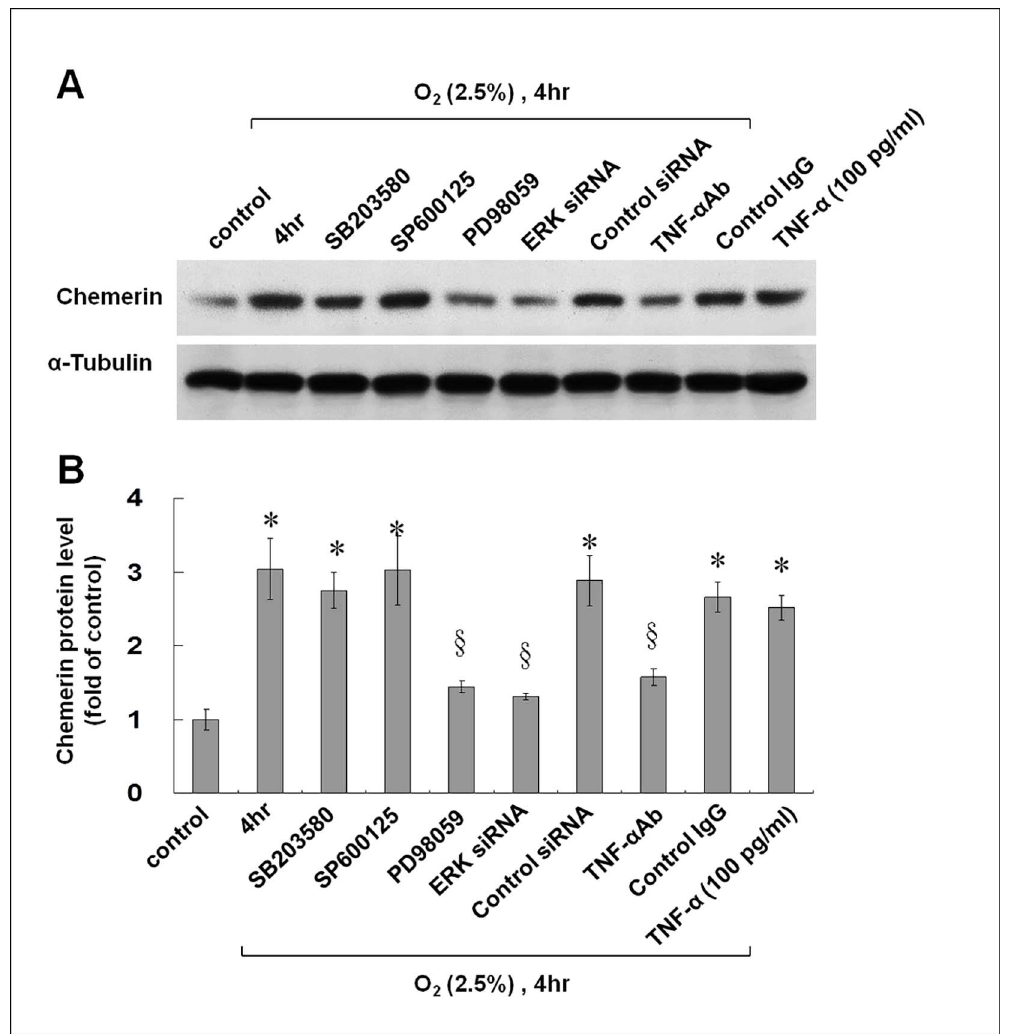
Fig 2. The ERK pathway mediates the hypoxia-induced increase in chemerin expression in HCAECs. (A and B) The hypoxia-induced increase in chemerin expressionwas blocked by an ERK inhibitor(PD98059), ERK siRNA, or an anti-TNF antibody. Additionof exogenous TNF—alpha during normoxia increasedchemerin expression (n = 4 per group); * p < 0.01 comparedto